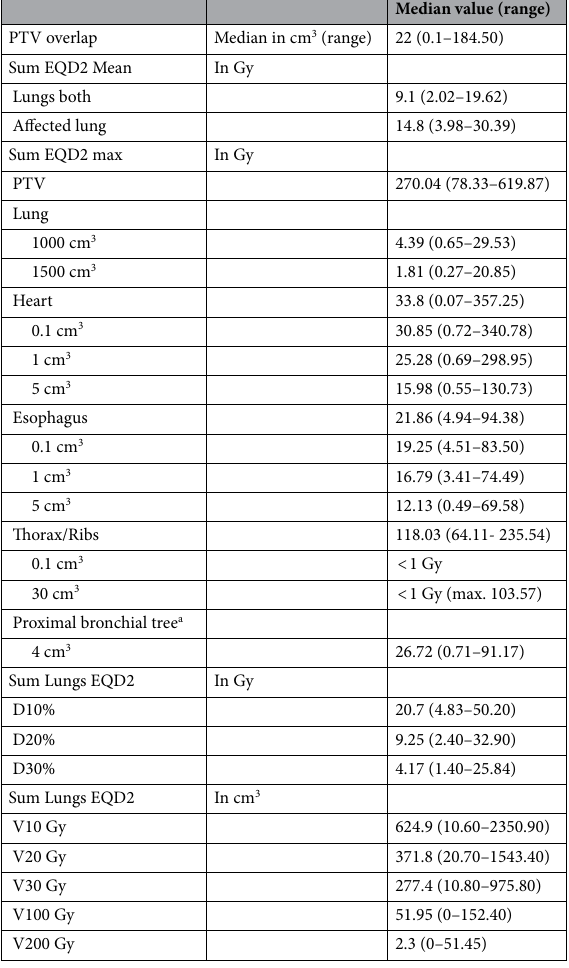
Table 3. Dosimetric data of the combined plans (also with respect to TG101 thresholds). a Evaluated only for 19 patients with central localization or any relevant dose. PTV, planning target volume; Dx%, dose received by x% of PTV; VxGy, volume receiving x Gy; EQD2, total equivalent dose in 2 Gy